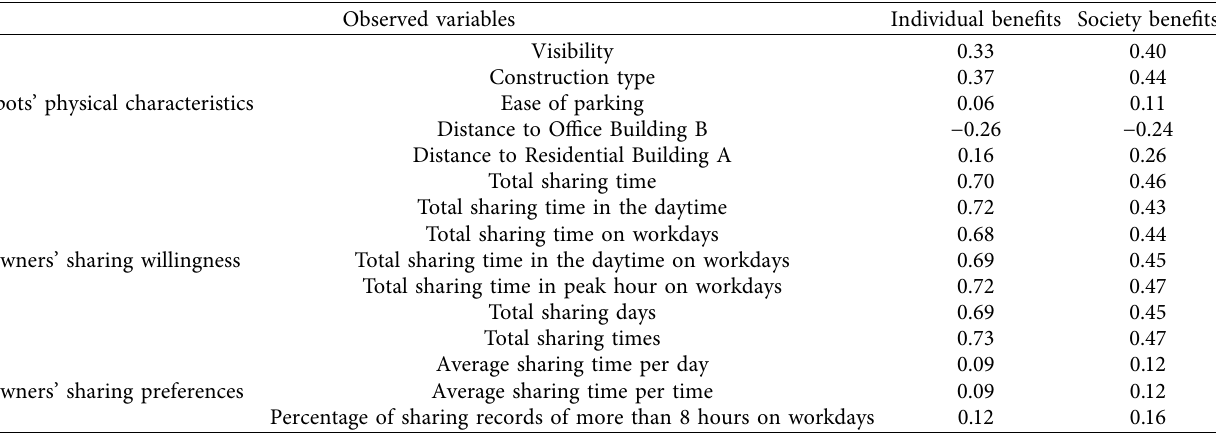
Table 4: Effects of observed variables on rental